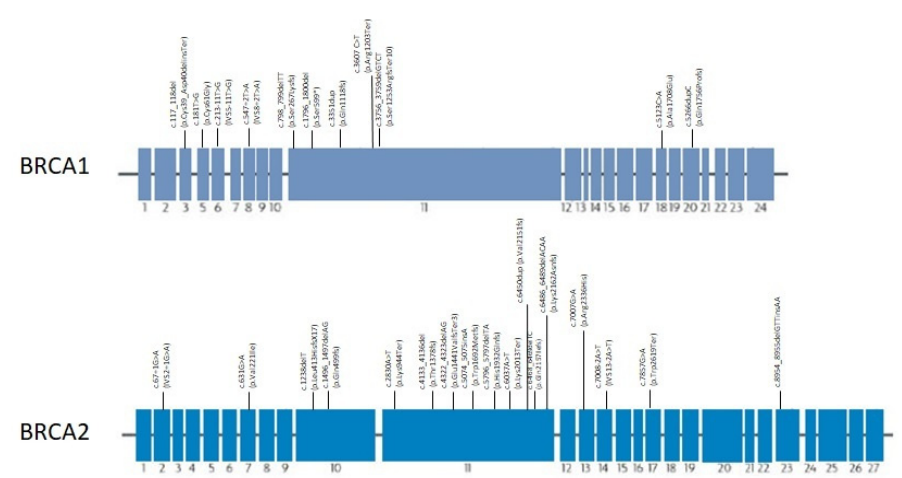
Figure 5. Pathogenic variants found in HBOC families with PCa localized through BRCA1 and BRCA2 genes.